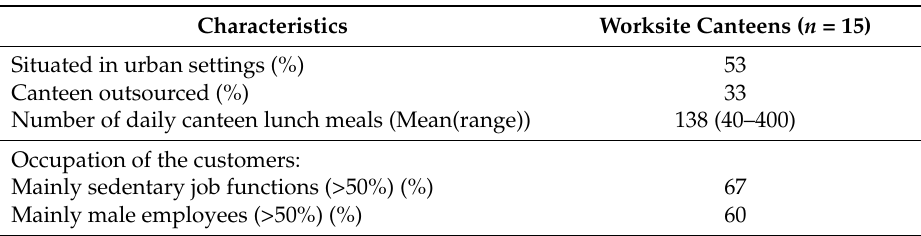
Table 1. Characteristics of participating worksite canteens.